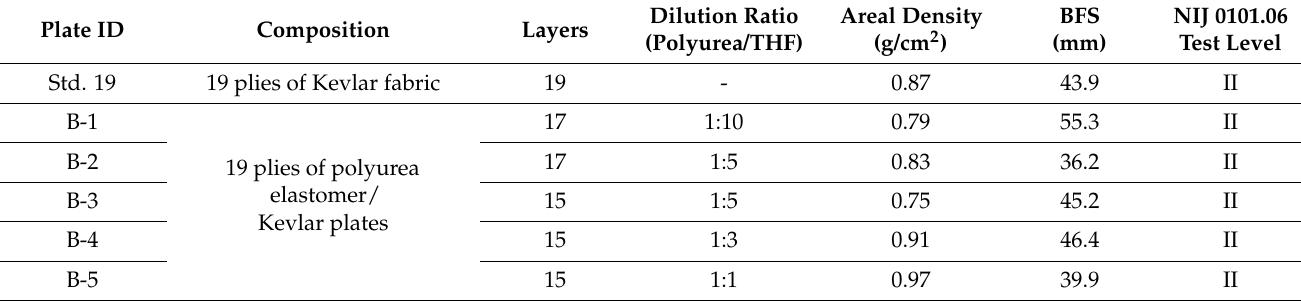
Table 2. Results for ballistic test of polyurea elastomer/Kevlar plates.